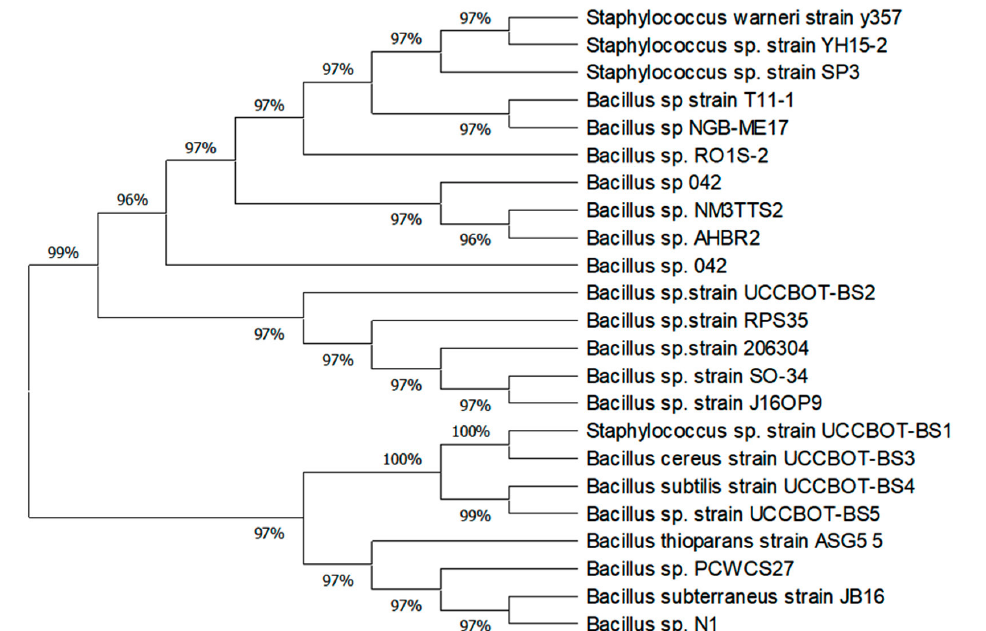
Fig. 2. Phylogentic tree showing the relationship of isolated endophytes and their nearest